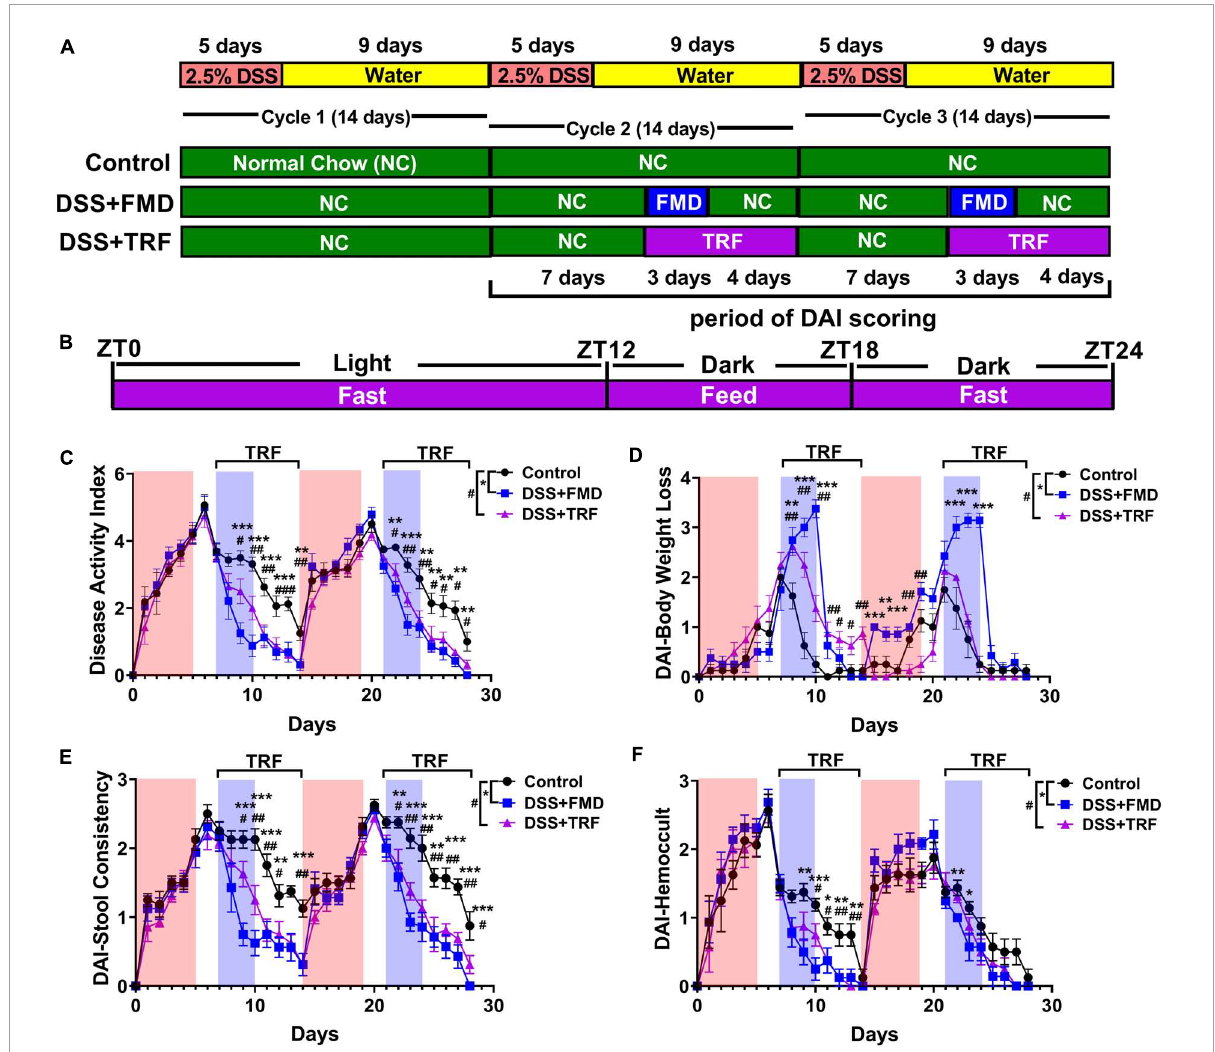
FIGURE1 TRF reduces disease activity index (DAI) and ameliorates IBD-associated symptoms in mice. (A) The schematic diagram of the experimental design. (B) The schematic diagram of TRF diet for each day during the intervention. (C) Cumulative DAI scores (excluding body weight loss score) that starting at the first day of cycle 2 ( n = 8 for each group). (D) DAI scores of body weight loss. (E) DAI scores of stool consistency. (F) DAI scores of hemoccult test. In (C–F) , the red shade denotes the duration of DSS treatment and the blue shade indicates the duration of FMD intervention, the duration of TRF is represented by the black bracket. Data are presented as mean ± SEM. The * sign represents the differences between the DSS + FMD group and the control group, and the # sign represents the differences between the DSS + TRF group and the control group (1 sign for P < 0.05, 2 signs for P < 0.01, 3 signs for P <